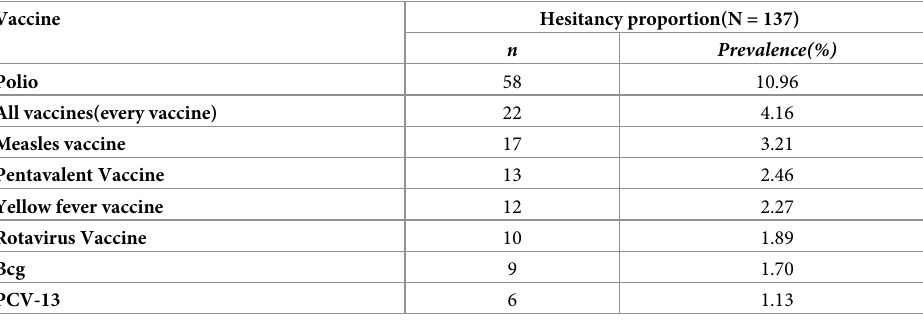
Table 3. Vaccine hesitancy prevalence in the general population by